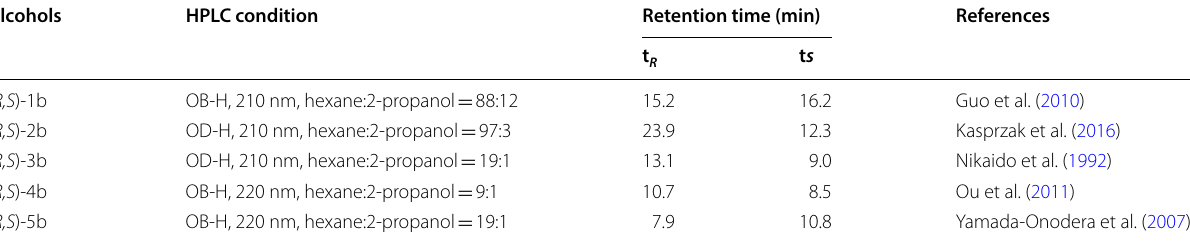
Table 2 Analytical methods of enantiomers of chiral alcohols